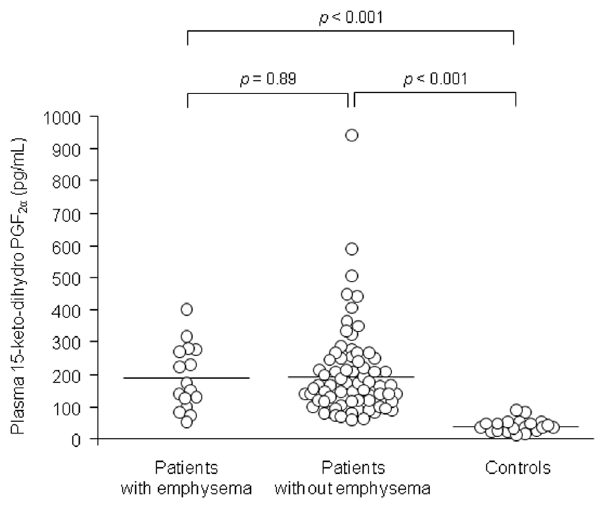
Figure 1. Comparison of plasma 15-keto-dihydro prostaglan- din F 2 a concentrations in patients and controls. Horizontal bars indicate mean values. There were significant differences in plasma 15- keto-dihydro prostaglandin F 2 a concentrations between IPF patients with emphysema (n=16) and controls (n=25), and IPF patients without emphysema (n=75) and controls. However, there was no difference in plasma 15-keto-dihydro prostaglandin F 2 a concentrations between IPF patients with emphysema and those without emphysema. doi:10.1371/journal.pone.0066017.g001 (FVC) ( Rs = 2 0.33, p =0.005), DL CO ( Rs = 2 0.36, p = 0.003), CPI ( Rs = 2 0.40, p =0.001), A-aDO 2 ( Rs = 0.39, p =0.002), 6-minute Table 1. Characteristics of patients and controls.